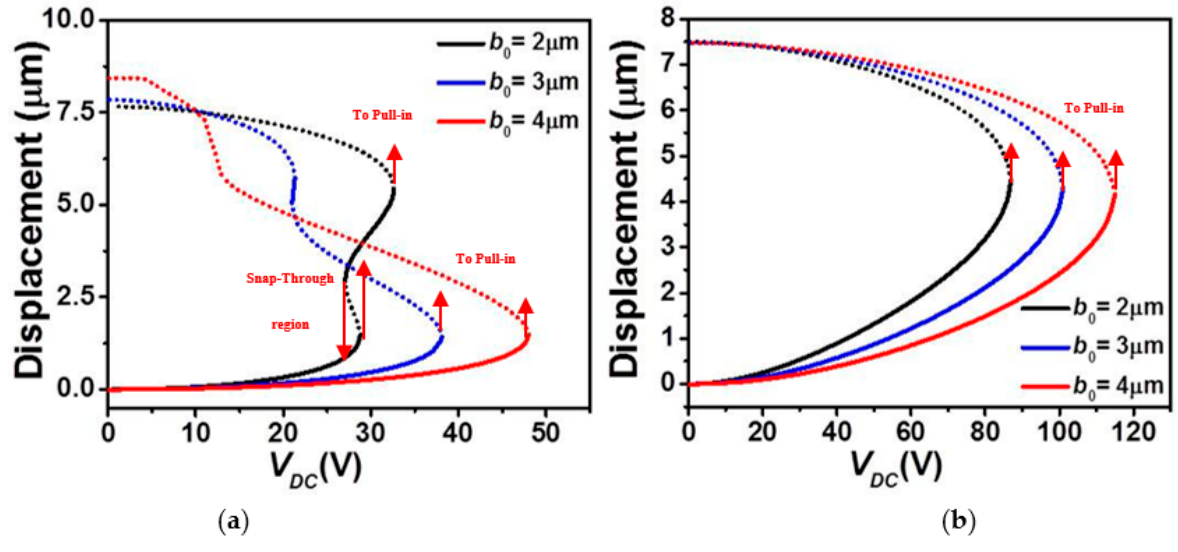
Figure 3. The static displacement of the micro-beam of Table 1 with a uniform g under V DC for various values of initial rise ( b 0 ) for ( a ) Case 1 and ( b ) Case 2 (solid: stable, dashed: unstable).